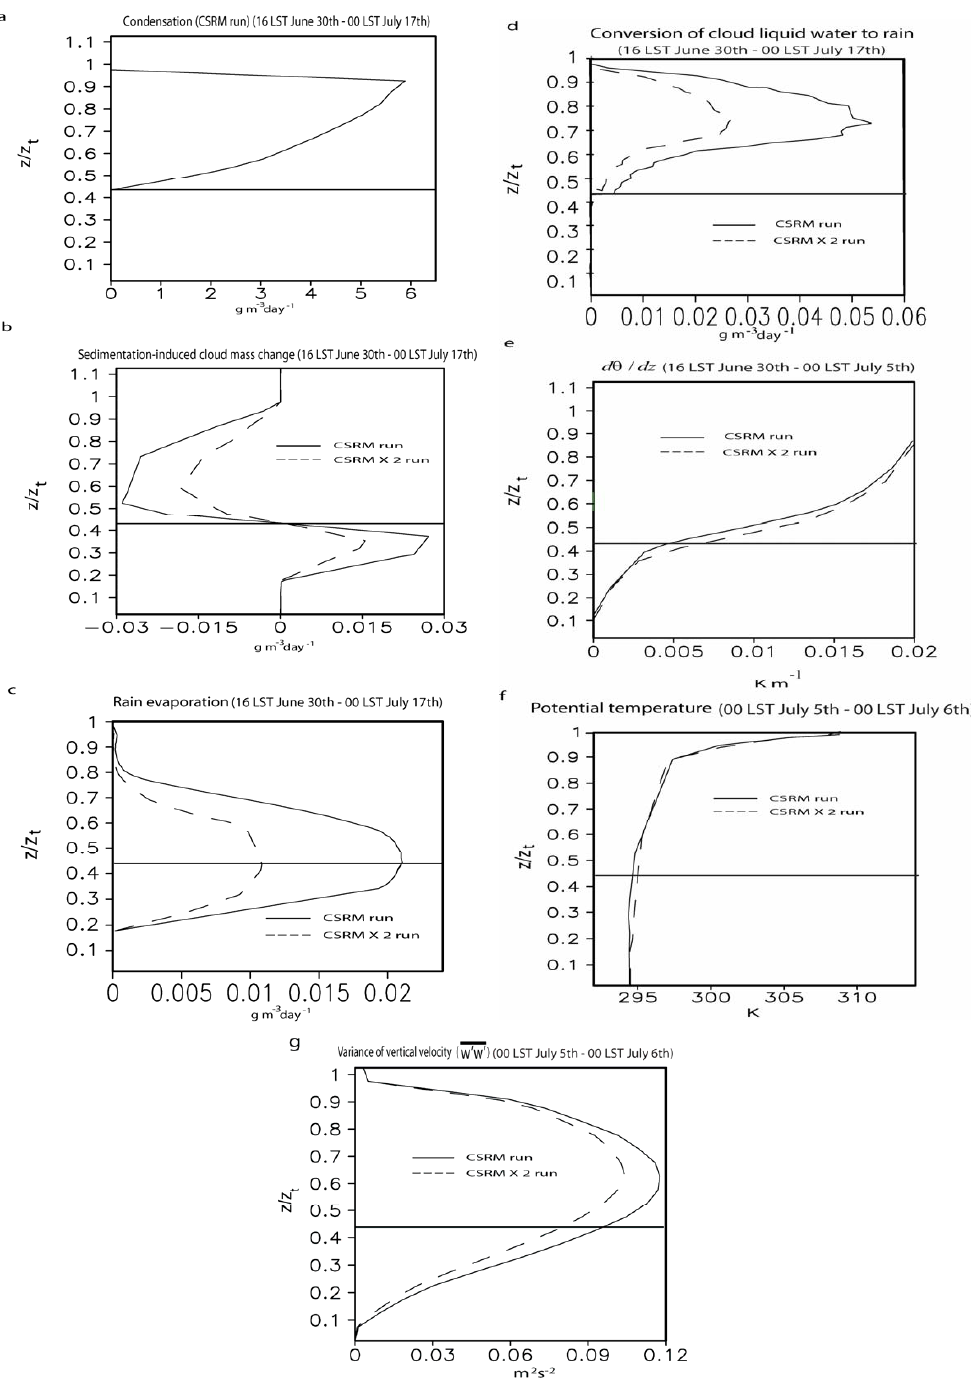
(Km − 1 ), θ (K), and w 0 w 0 (m − 2 s − 2 ), dz